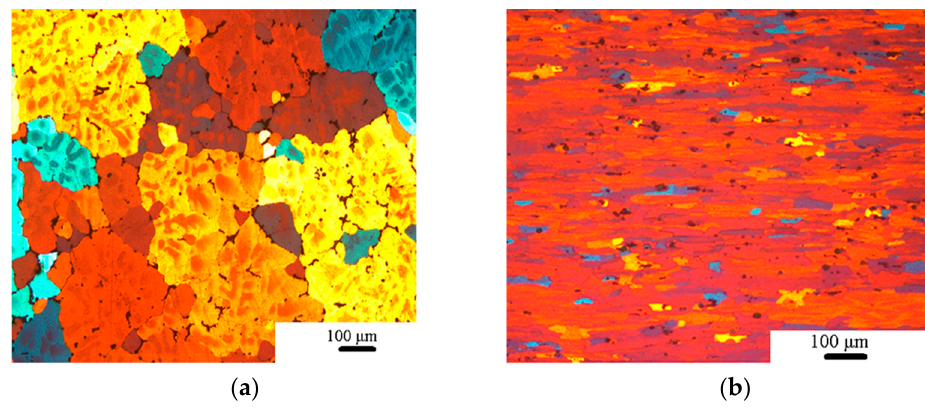
Figure 10. Results of Al Mg 4.5 Mn 0.3 (AA5182) andAlMg 6 Mn 0.7 (1565ch) alloys optical microscopy results of the as-cast structure ( a ) and after reversing mill ( b ).